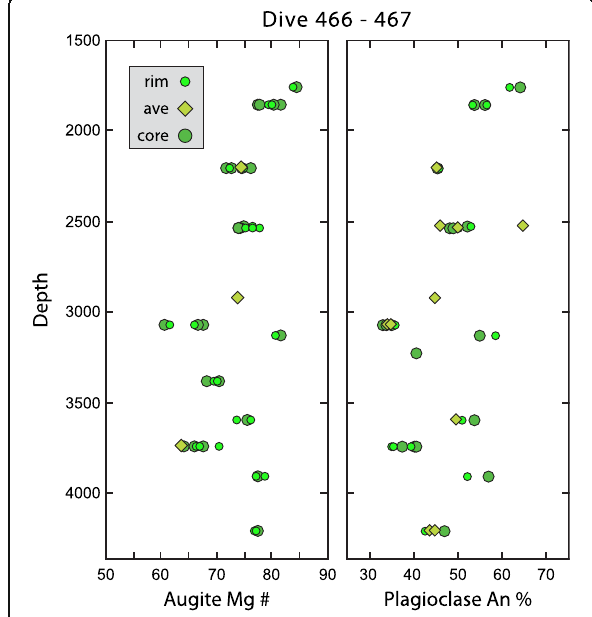
Fig. 26 Augite Mg# and plagioclase anorthite content plotted against sampling depth for Shinkai 6500 Dives 466-467 on the north wall of Atlantis Bank (Fig. 3). These dives represent a continuous traverse of the largest gabbro exposure at Atlantis Bank, ending at the contact with the mantle on the transform wall. This shows that the contact is not a depositional one representing the gabbro- peridotite contact, but rather an intrusive contact where evolved gabbro intruded laterally into the mantle in the transform